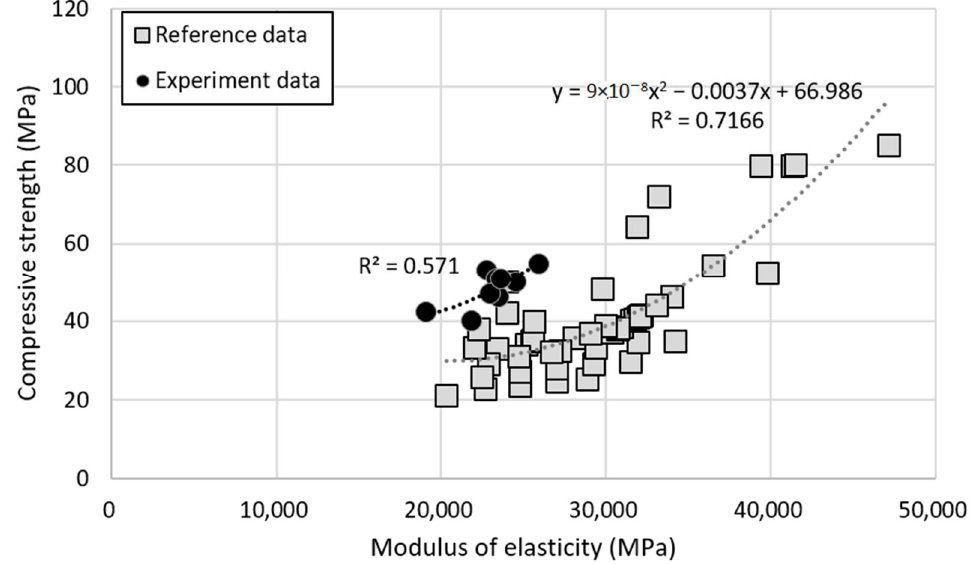
Figure 15. Relation between modulus of elasticity and compressive strength of recycled aggregate concrete.